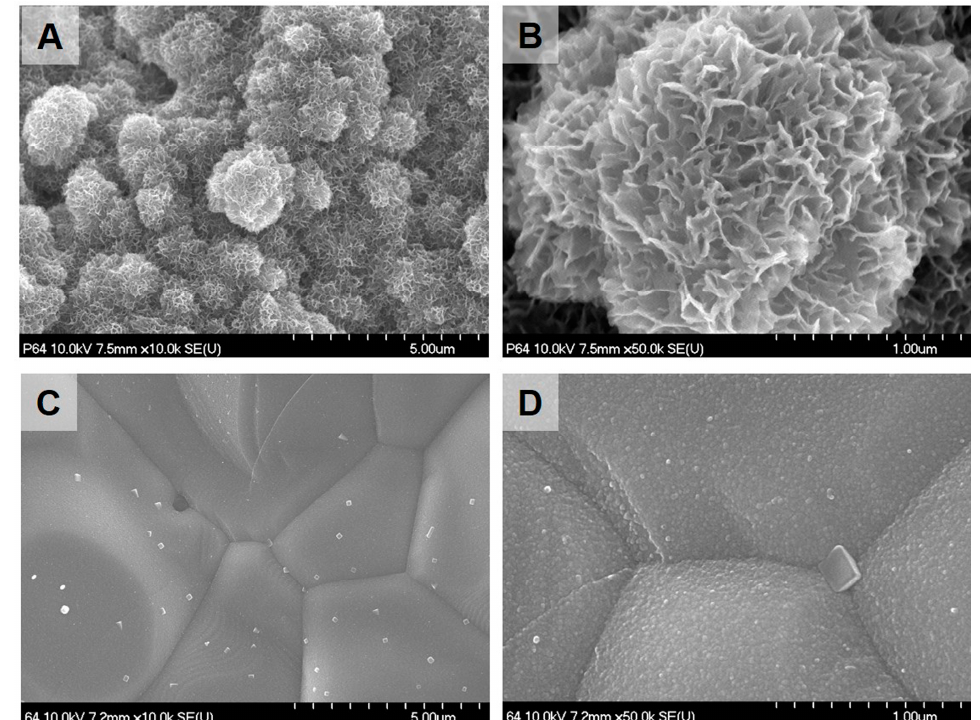
Figure 3. Bioactivity of biphasic ceramic immersed in SBF at 37 °C for three days. Precalcified biphasic ceramic (CP-BC) showed large, dense aggregates of crystalline structures on the surface ( A , B ); untreated biphasic ceramic (BC) did not show any changes on the surface ( C , D ).